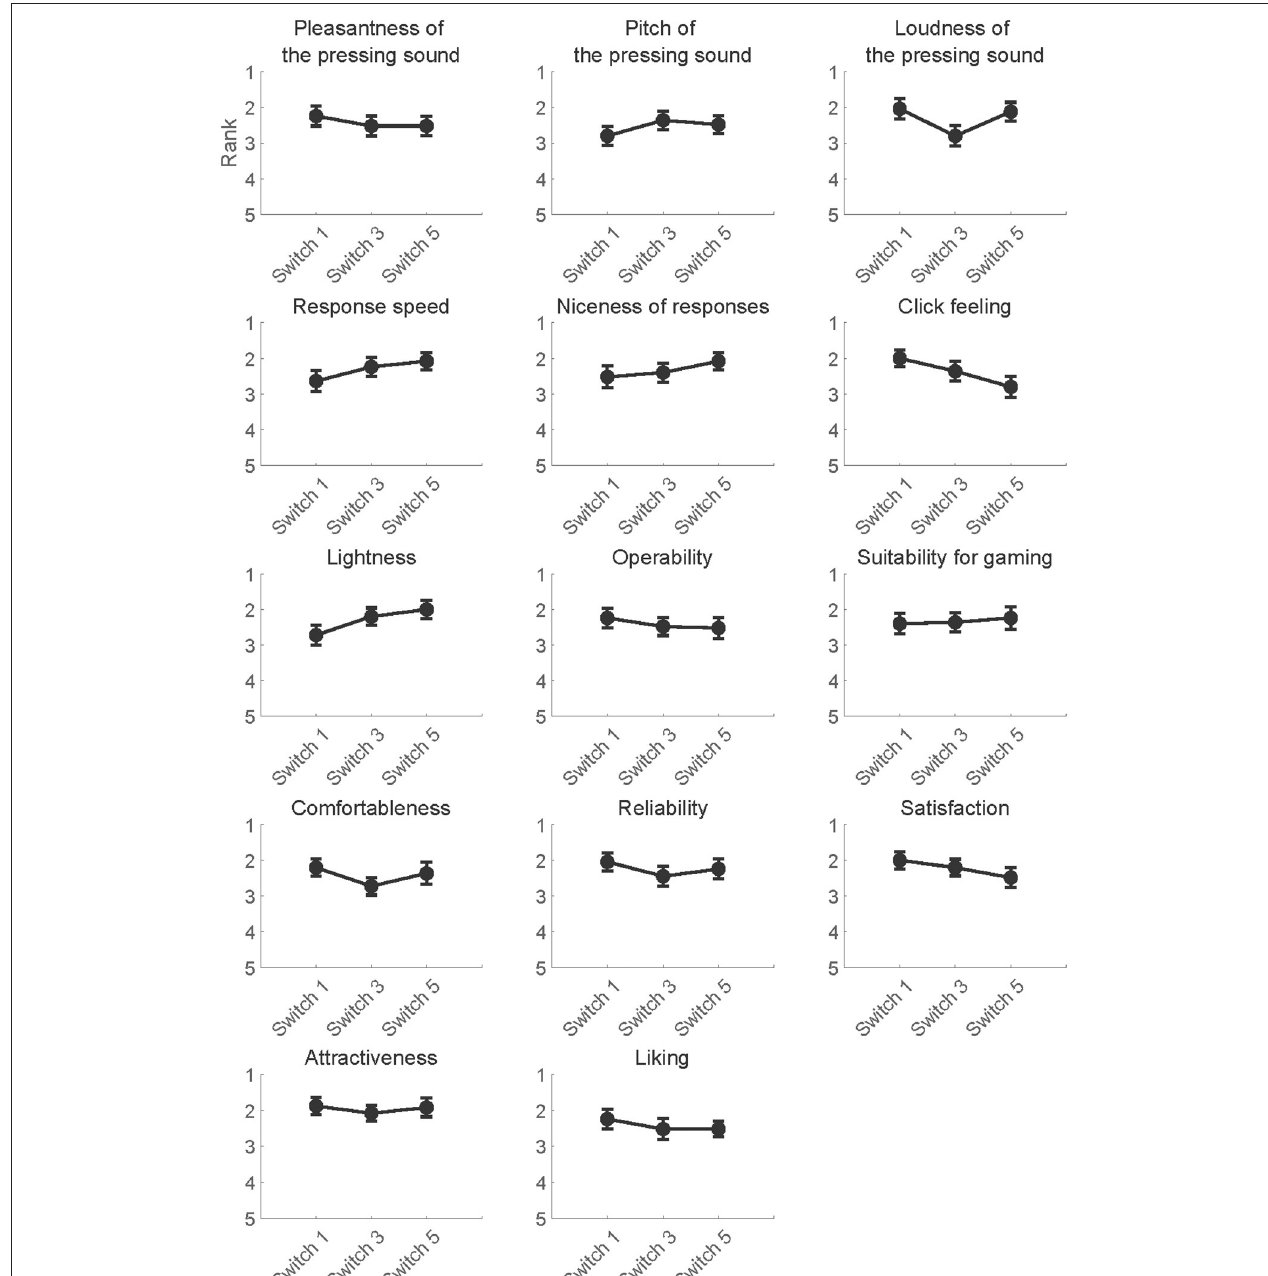
FIGURE 6 | The mean subjective rankings of switches per question